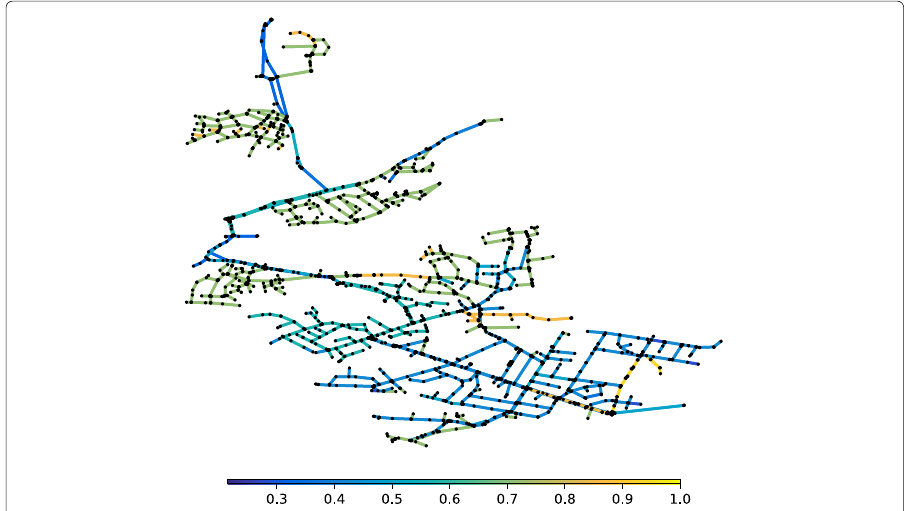
Fig. 5 Analysis of the roughness of BWFL pipes. The colour of the links represent the normalised roughness coefficient of the pipes. Compared to Net3, BWFL is geographically heterogenous with regards to pipe